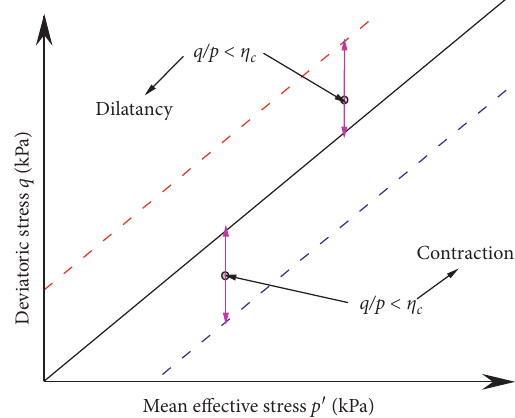
Figure 1: Relationship between the critical state stress ratio and